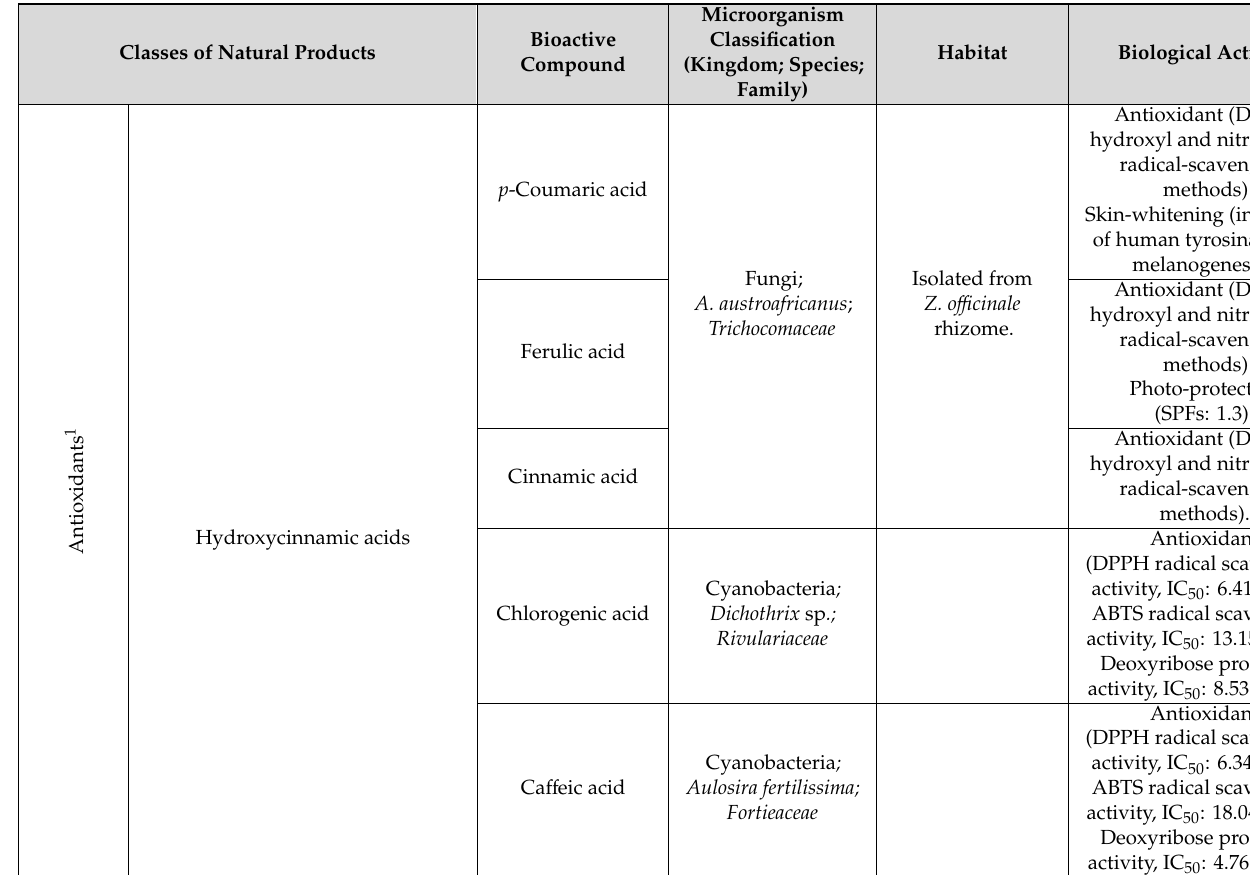
Table 1. Bioactive molecules produced by terrestrial